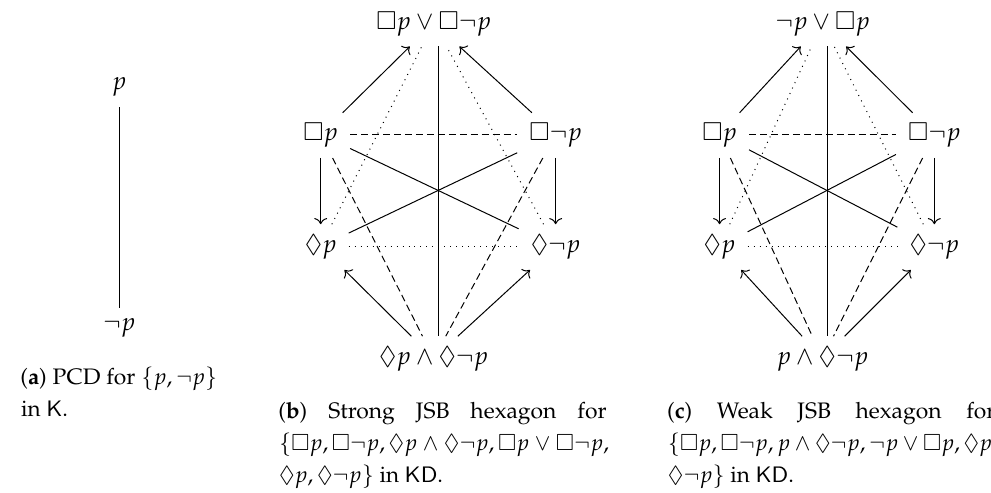
Figure 2. Three further examples of Aristotelian